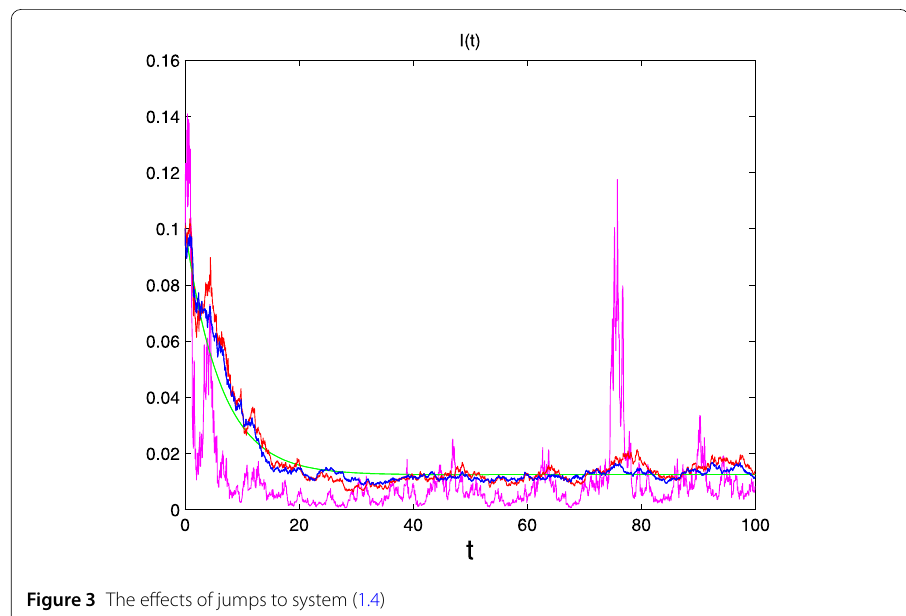
Figure 3 The effects of jumps to system